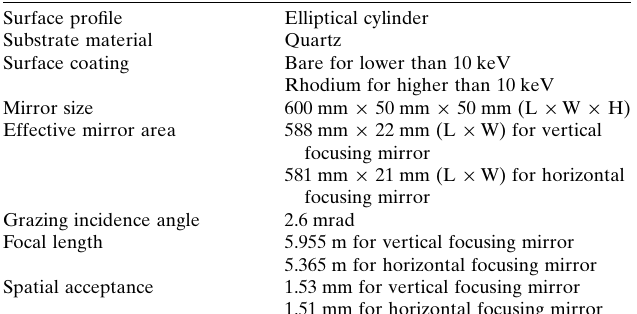
Table 2 Summary of the key parameters for the focusing optics – the K-B mirror. Surface profile